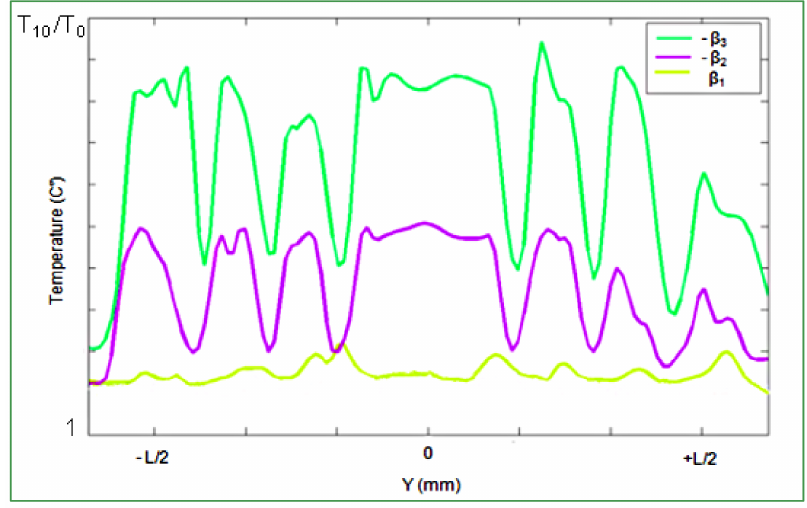
Figure 7. The variation of skidding angles for a constant loading l 3 = 200 kN at velocity up to 190